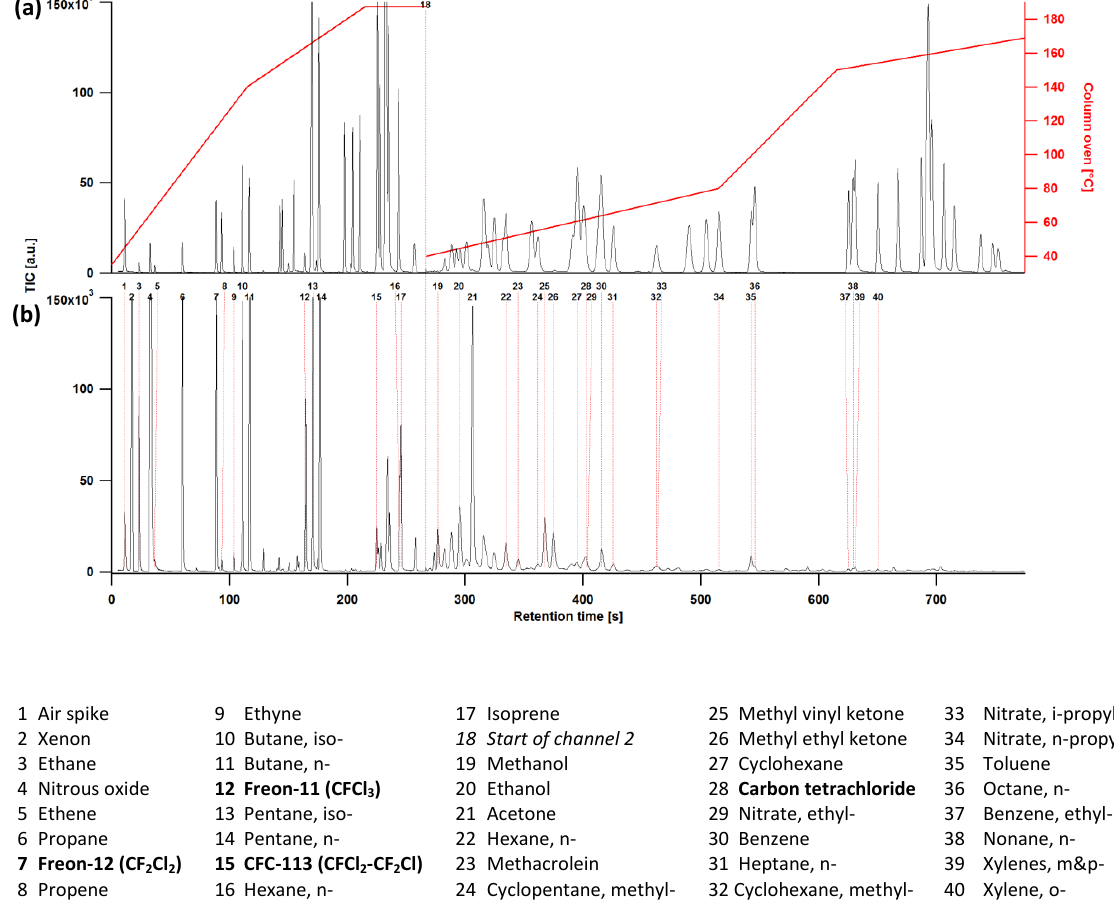
Figure 4. Chromatograms displayed as total ion current (TIC) with select peaks identified. Top panel (a) shows secondary standard, along with temperature ramp for each GC channel. Bottom panel (b) shows air sample collected in the Haynesville oil and gas field near Shreveport, Louisiana, 25 April